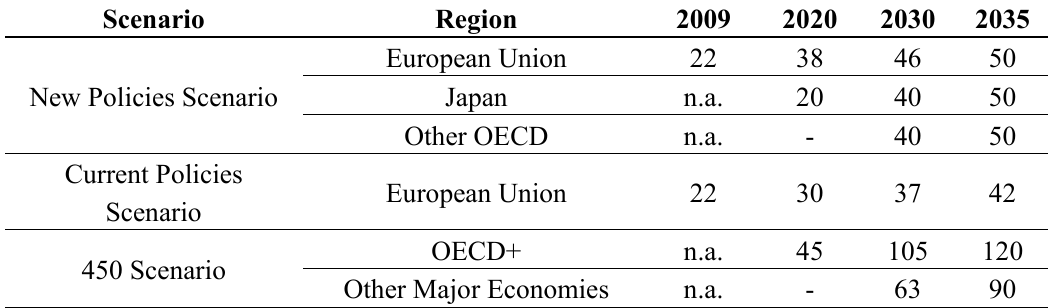
Table 4. CO prices by main region and scenario ($2009 per tonne) 2